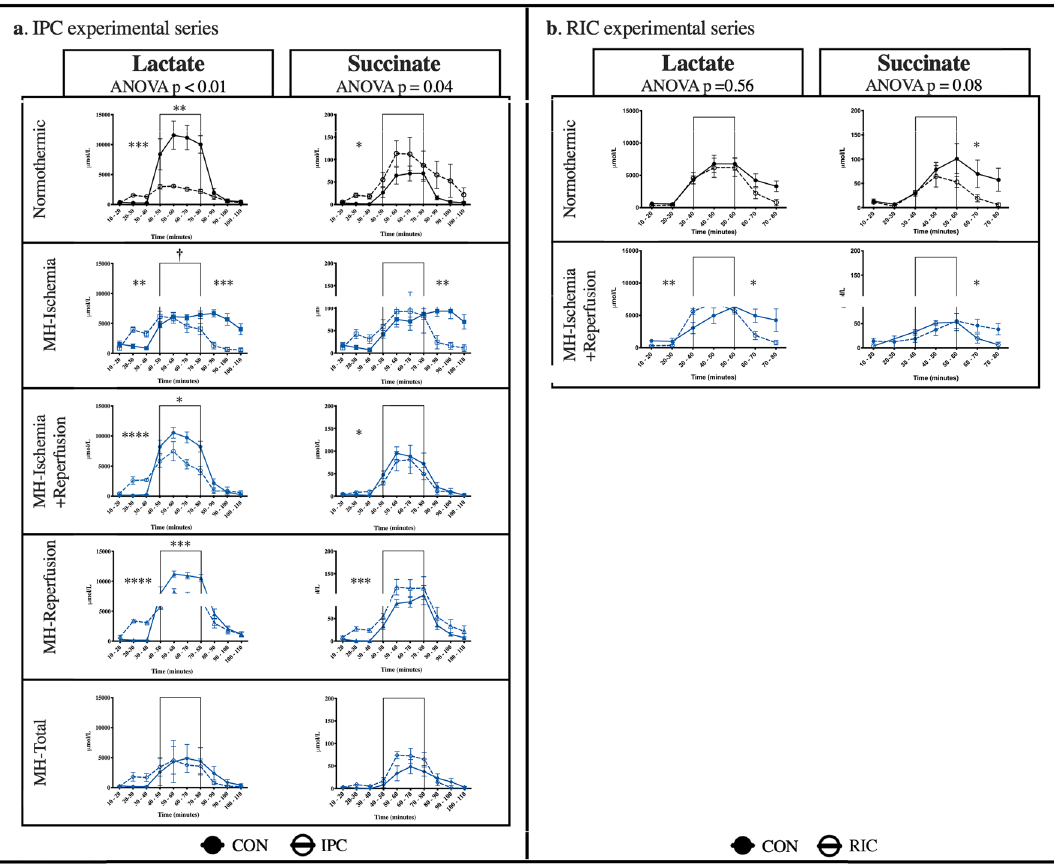
Figure 4. Microdialysis. ( a ) IPC experimental series, ( b ) RIC experimental series. CON control, IPC ischemic preconditioning, RIC remote ischemic preconditioning, MH-Ischemia mild hypothermia during ischemia, MH-Ischemia + Reperfusion mild hypothermia for last 20 min of ischemia and throughout reperfusion, MH-Reperfusion mild hypothermia during reperfusion, MH-Total mild hypothermia through the total protocol. † P represents comparison between normothermic CON and CON MH-groups. *p represents comparison of CON and IPC according to MH-protocol. *p < 0.05, **p < 0.01, ***p < 0.001, ****p <